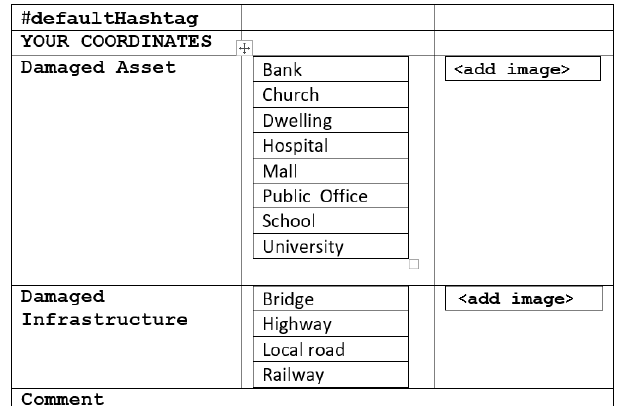
Figure 1. The app